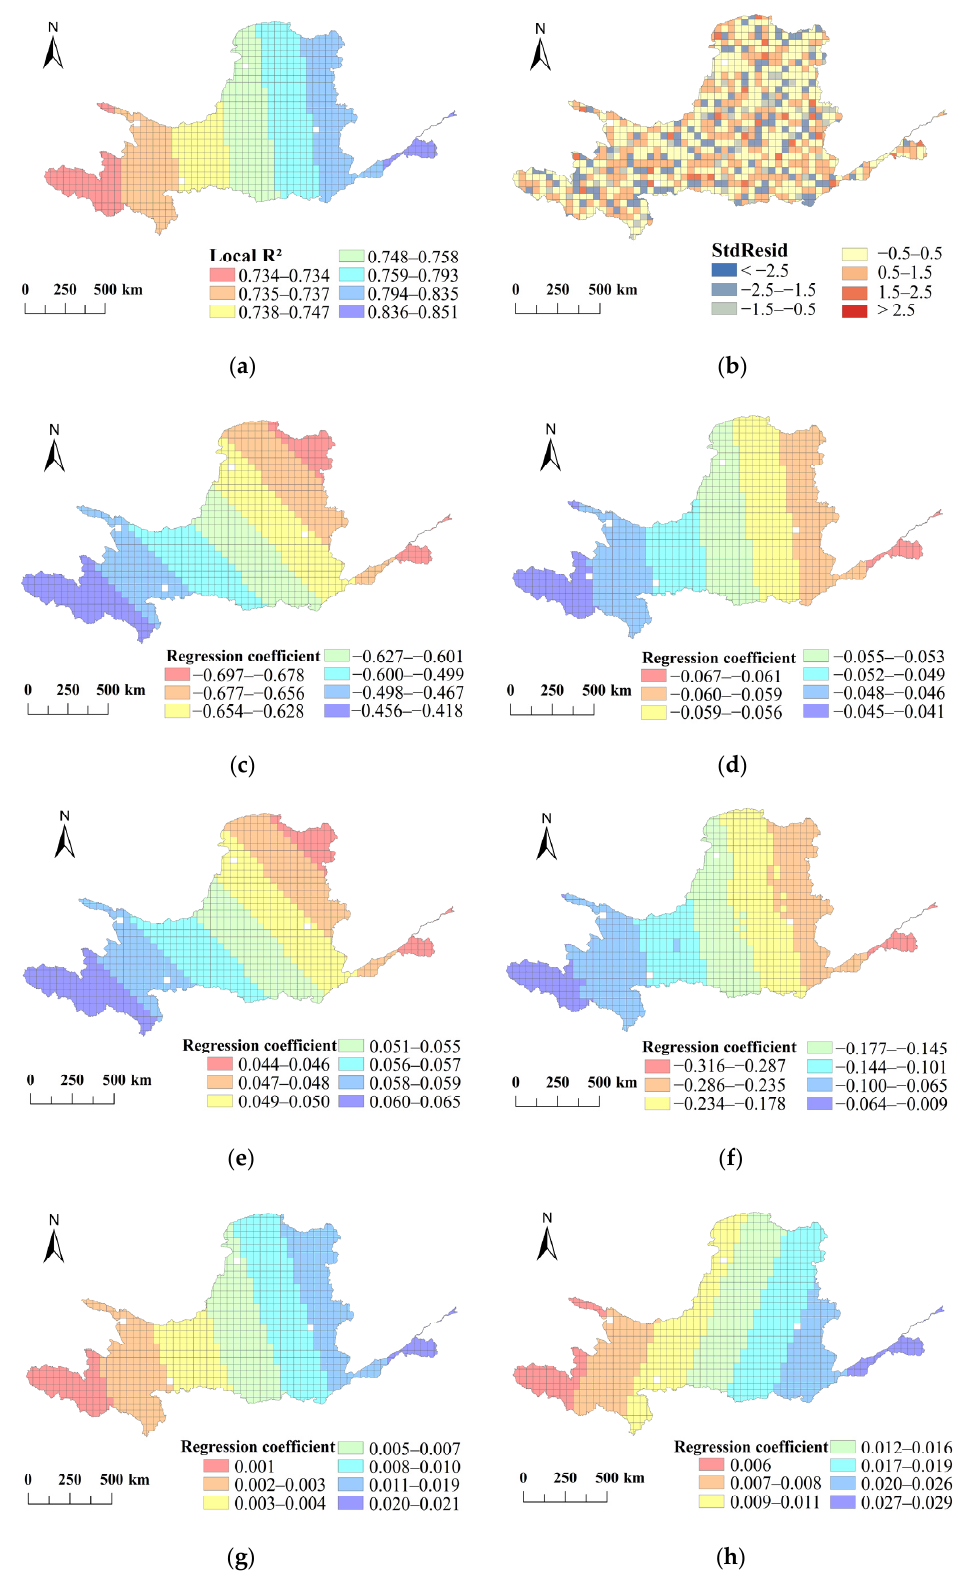
Figure 4. Influence degree of topography on river network structure at the 40 km analysis scale. ( a ) Local 𝑅 (cid:2870) ; ( b ) Standardized residual of the coefficient; ( c ) The width of the multifractal spectrum; ( d ) The difference in the multifractal spectrum; ( e ) Slope; ( f ) Average elevation; ( g ) Elevation maximum; ( h ) Elevation minimum.